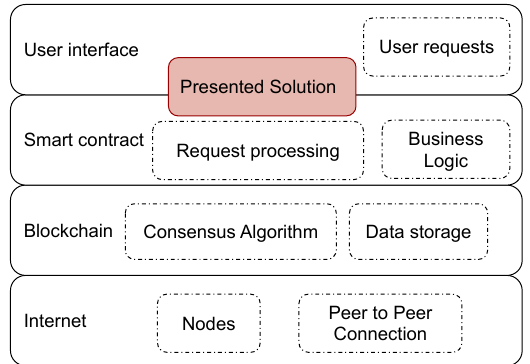
Figure 1. Decentralized app